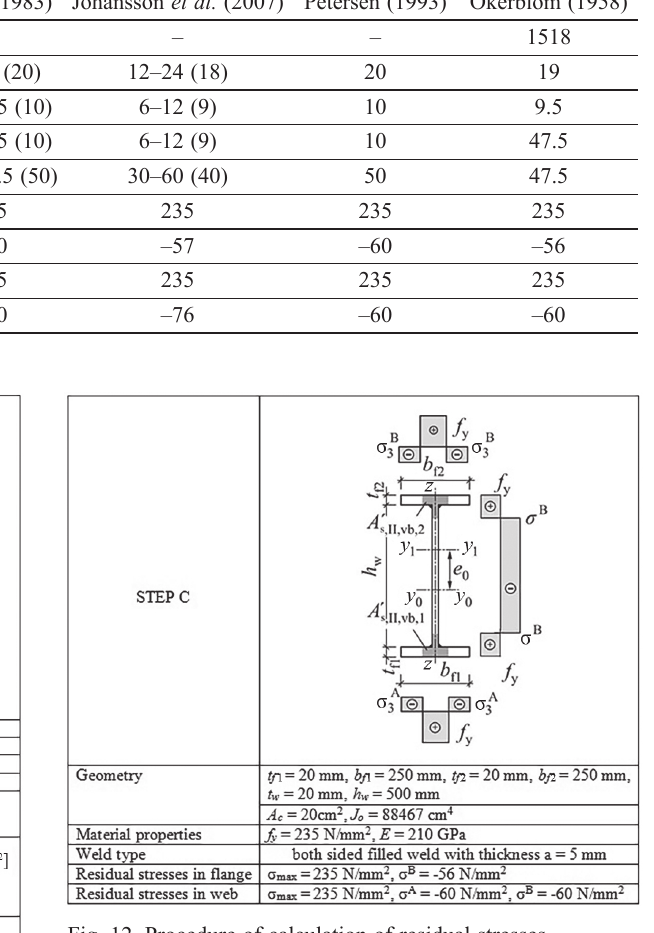
Fig. 12. Procedure of calculation of residual stresses for i cross-section in step c